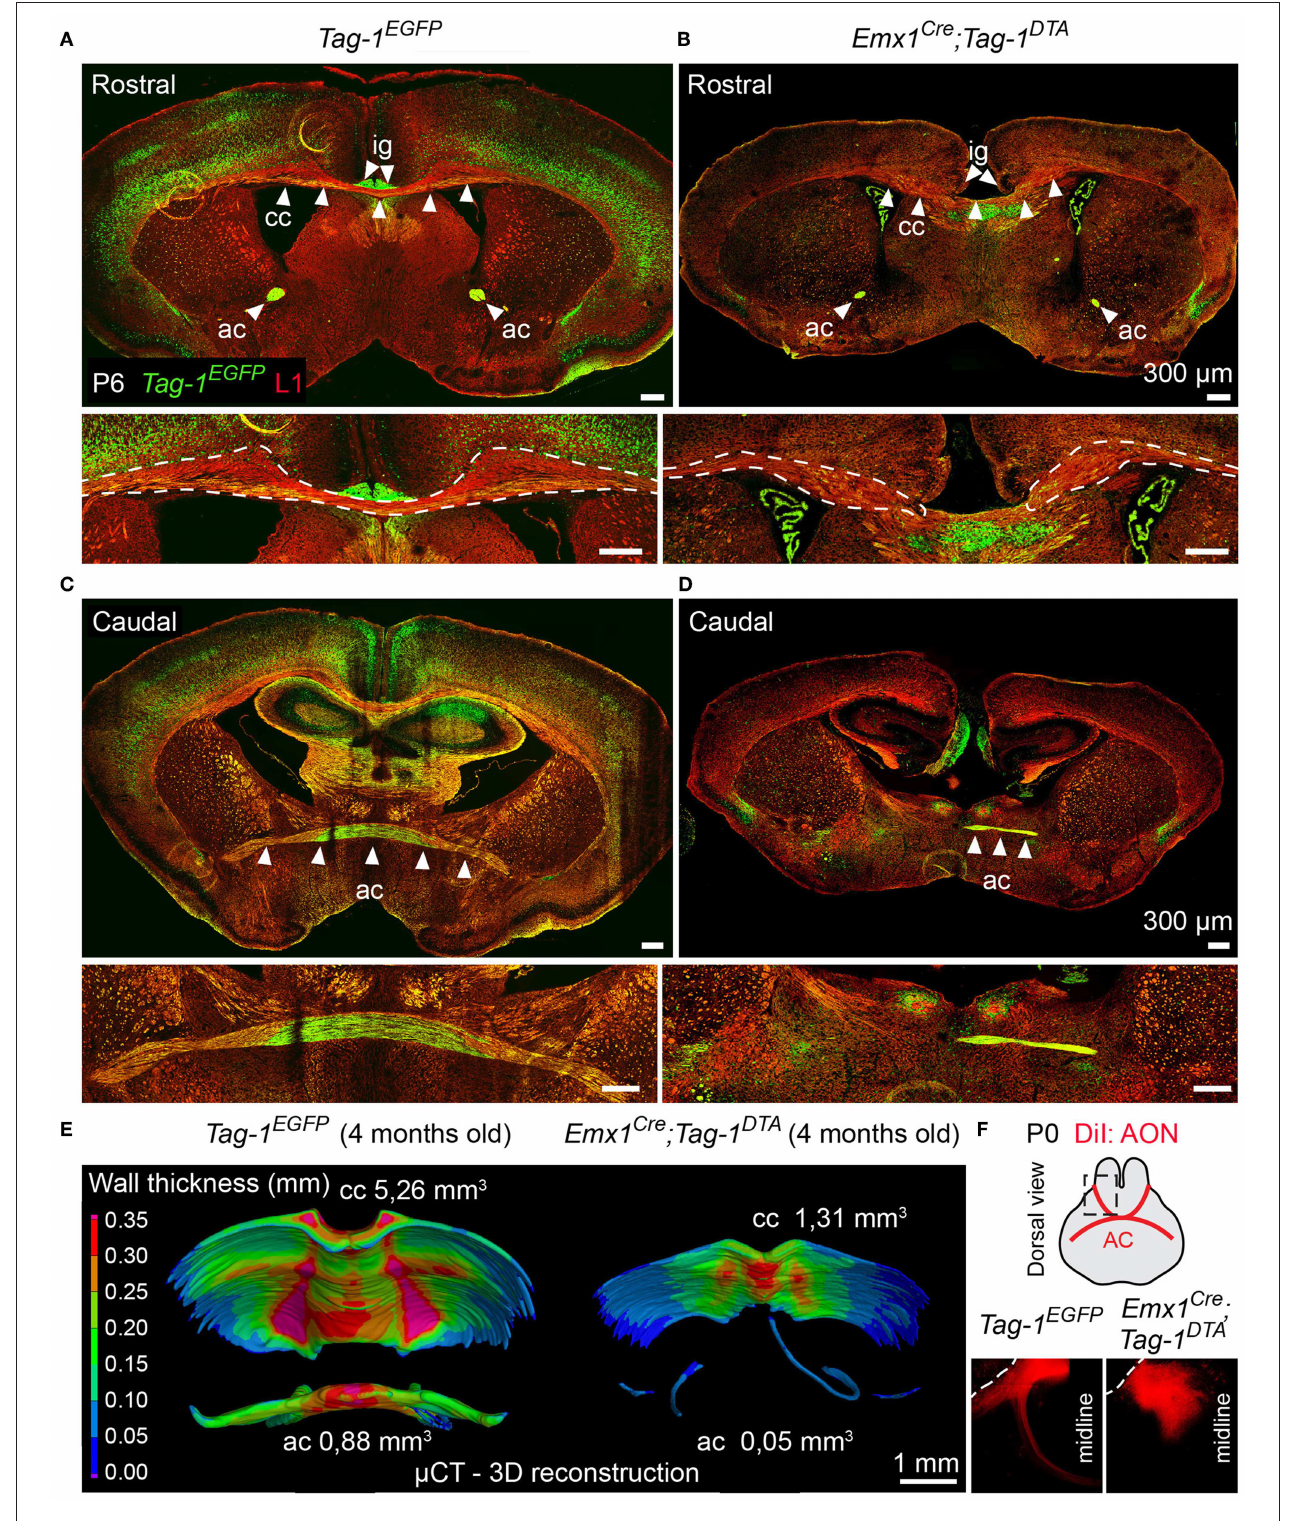
FIGURE 9 | Targeted ablation of TAG-1 + neocortical neurons affects severely the corpus callosum and anterior commissure. (A–D) Immunofluorescence against EGFP and L1 on P6 forebrain in Tag-1 EGFP and Emx1 Cre ;Tag-1 DTA mice at a rostral (A,B) and caudal (C,D) level of the P6 forebrain in in Tag-1 EGFP